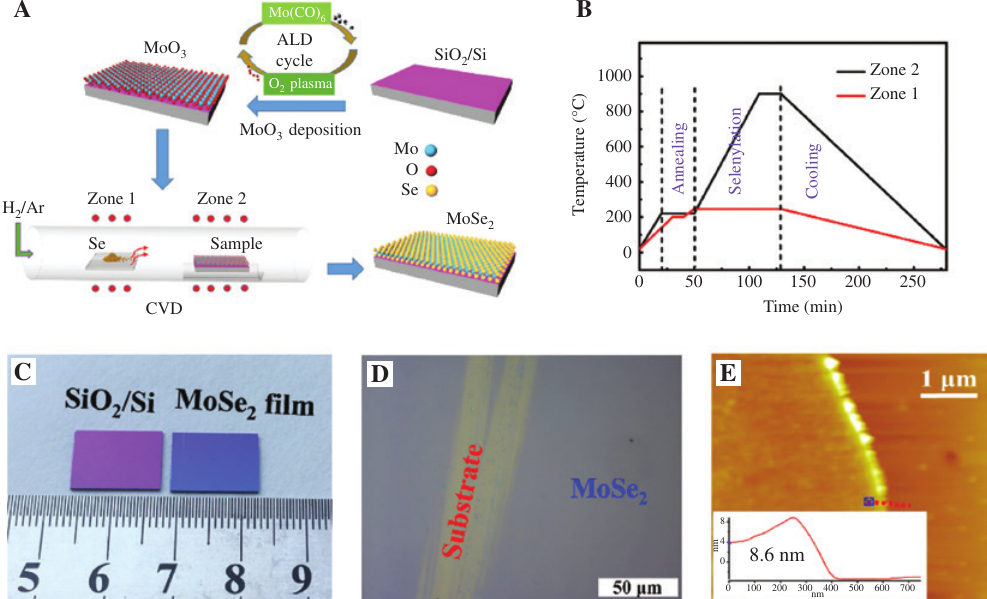
film. 2 with ALD and a CVD method. MoO 2